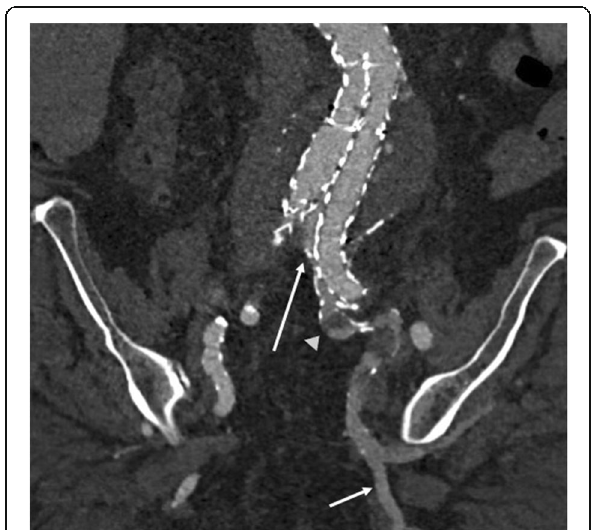
Fig. 2 Reformatted CT angiogram image showing contrast filling of left internal iliac artery (arrowhead) and type II endoleak in the aneurysm sac (short arrow). The anterior division of the left IIA is demonstrated with the long arrow